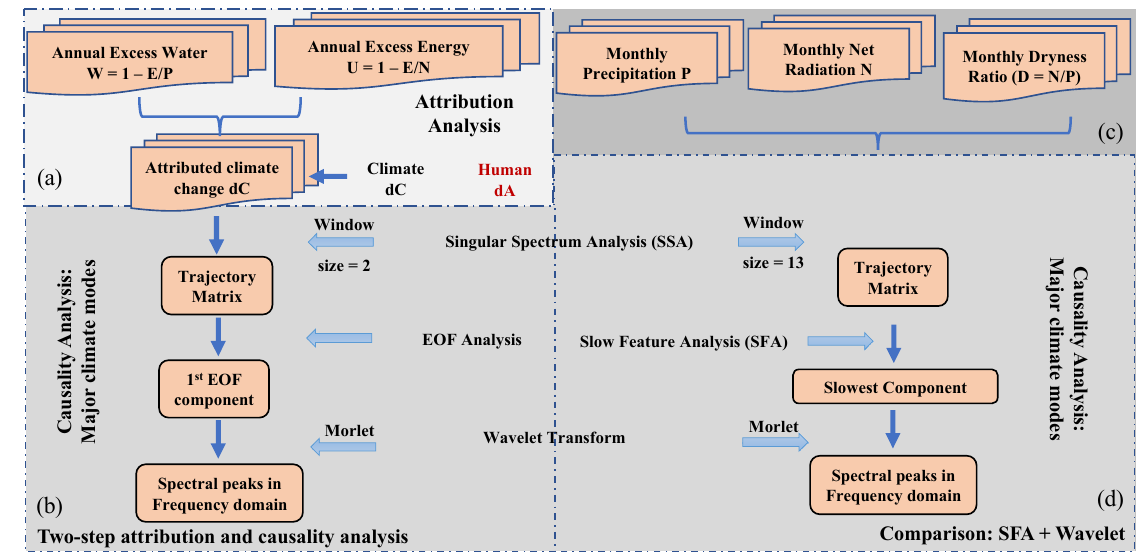
Figure 2. Flowchart of the two ‐ step attribution and causality analysis on inter ‐ annual scale (left, ( a ) and ( b ) versus slow feature analysis of causality on monthly scale (right, ( c ) and ( d )). Input: ecohydrological indices and fluxes of water supply and demand (pink in ( a ) and ( c )). Methods: attribution analysis (yellow in ( a )) and causality analysis (blue in ( b ) and ( d ) with stepwise results (pink in ( b ) and ( d )).